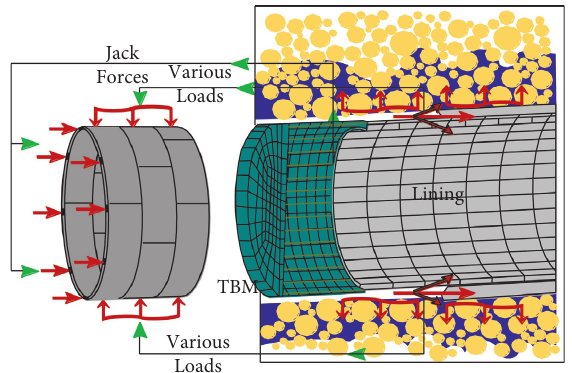
Figure 1: Various loads acting on the linings during construction (including grouting and earth and water